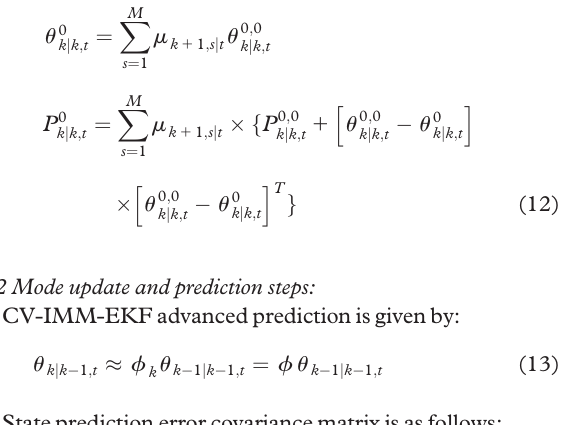
and s ay ; k (cid:3) 1 ¼